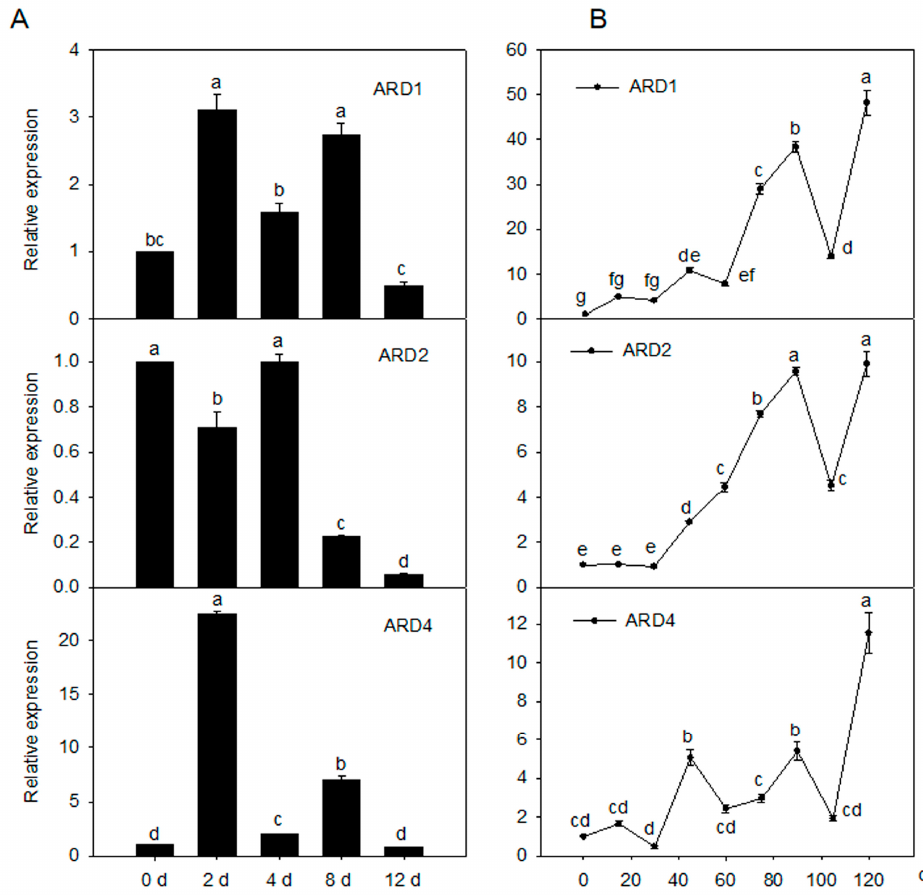
Figure 2. The expression pattern of MdARDs. ( A ) Change in the relative transcript level of MdARDs in response to the cold treatment, the expression level of MdARD1 , MdARD2 , or MdARD4 in response to cold on Day 0 was set as 1 and ( B ) trends in relative expression of MdARDs at different developmental stages of the apple fruit. Samples from 0 days after bloom (DAB) were set to 1. Expression levels were calculated relative to that of ELONGATION FACTOR1 α ( EF-1 α ). Bars represent the mean value ± SE ( n ≥ 3). Different letters indicate significant differences of MdARDs expression level on the different day of treatments, according to one-way ANOVA Tukey’s multiple range tests ( p < 0.05).